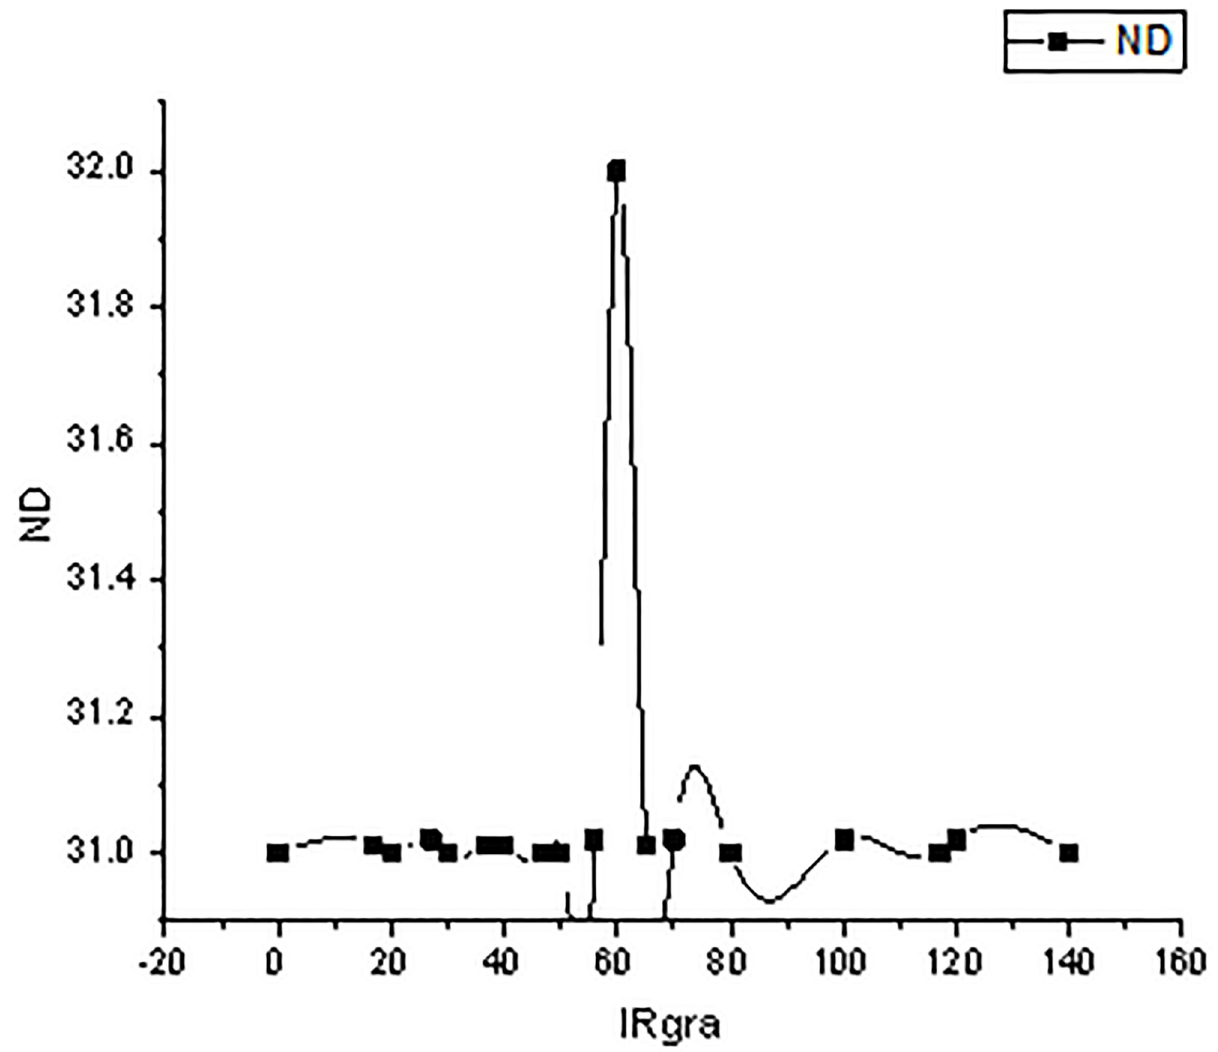
Fig 4. The new dynamic energy change whit the progressive change of manufacturing enterprises in the first